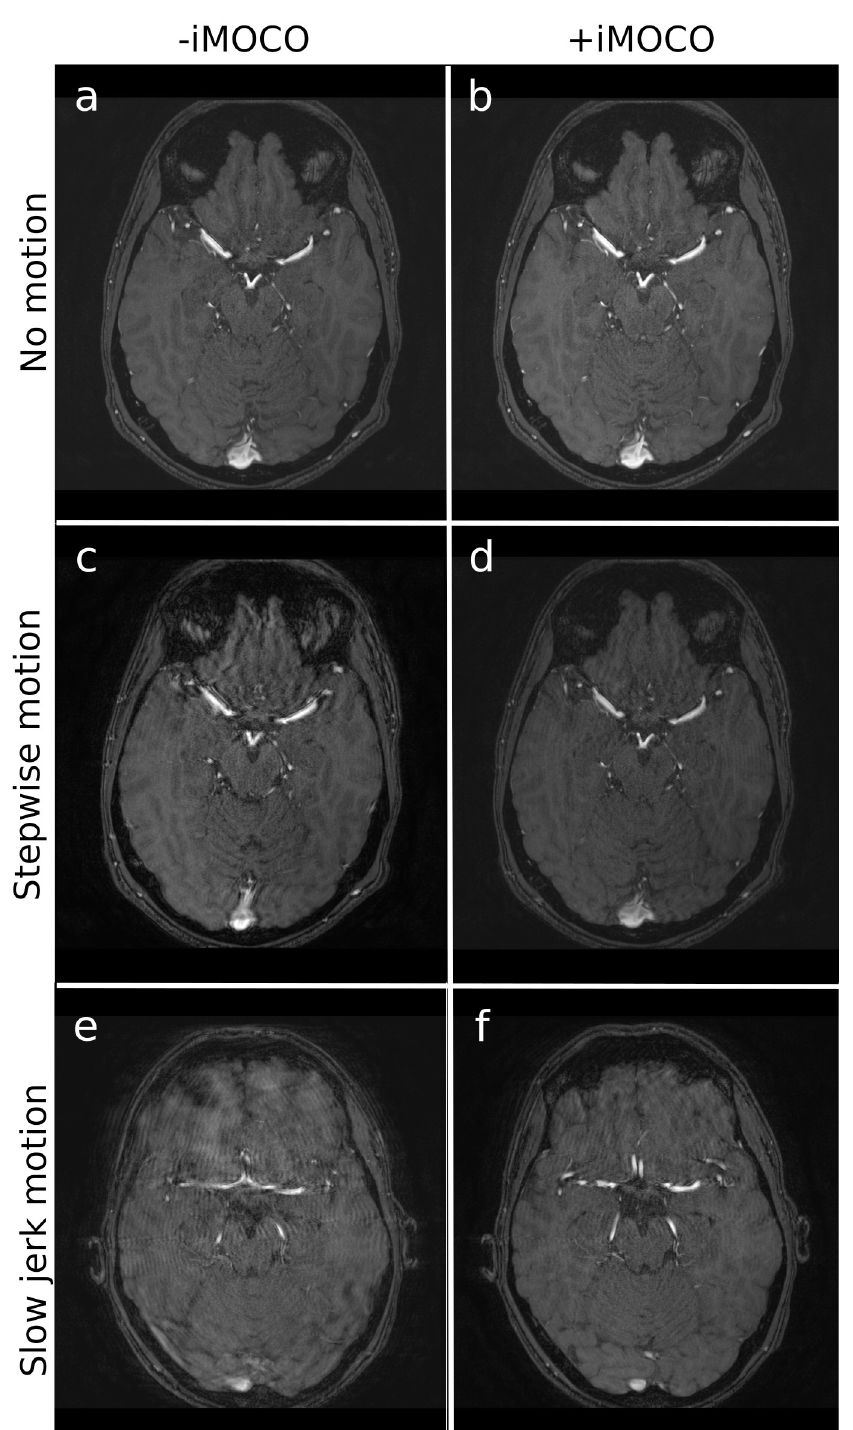
Fig 4. Examples of TOF scans with (+) and without (-) iMOCO for different types of movement. Panels a – d are from subject 1, while e and f are from subject 7. The scans in panels a and b were given a grading of 3 in all quality criteria. The scans in c and e were performed with motion but -iMOCO, and were graded 1 in all criteria. The corresponding cases +iMOCO were given higher gradings, i.e. panel d was grade 3 in all criteria except general image impression (grade 2), and panel f was grade 2 in all